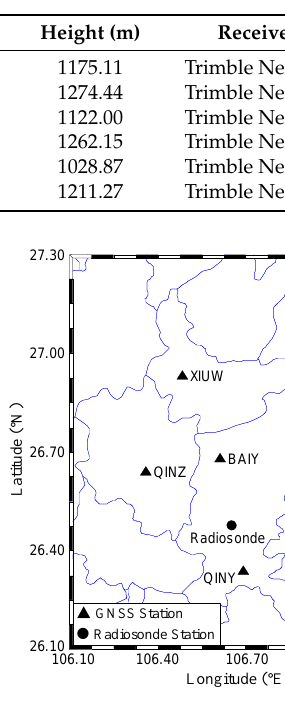
Figure 1. Geographic distribution of the selected ground-based GNSS stations in Guiyang and the radiosonde station located in the tomographic area.